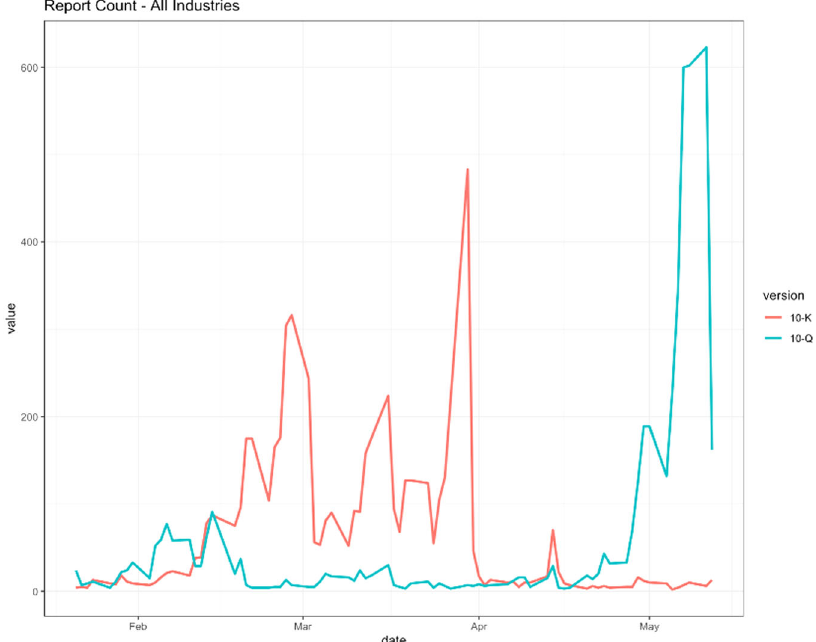
metric (Aroussi, 2019) for the sentiment that companies — and industries in aggregate — attribute to a certain topic. We further weight the (a) text negativity measure by (b) the number of ‘ corona ’ -keywords per report to re fl ect how encompassing a company and industry addresses the topic of Covid-19.